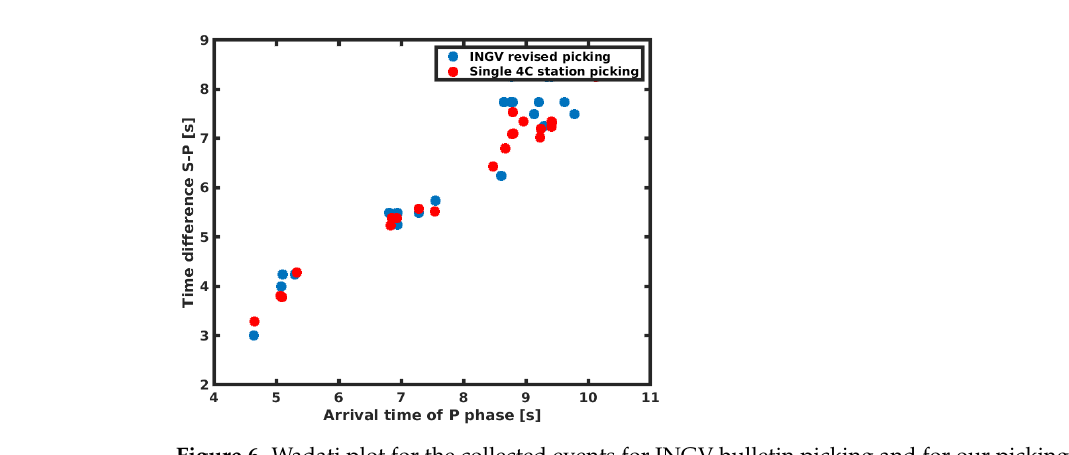
we get reasonable values of v p / v s = 1.73, vp = 5.1 and v s = 2.9. The values obtained are reported in Figure 7.